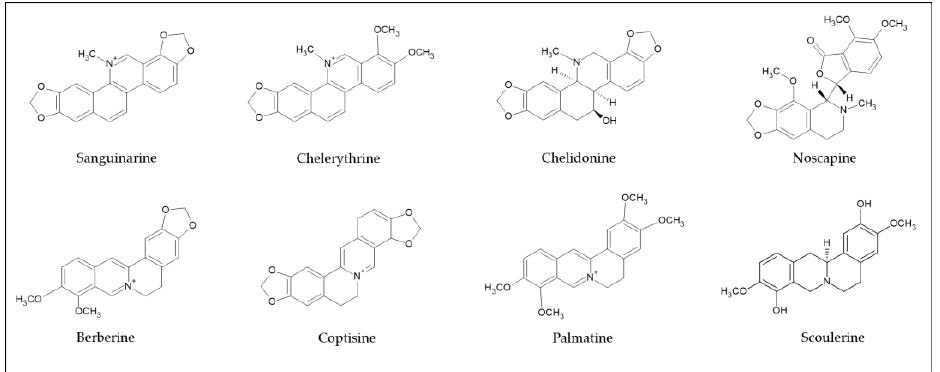
Figure 1. Synthesis of isoquinoline alkaloids.